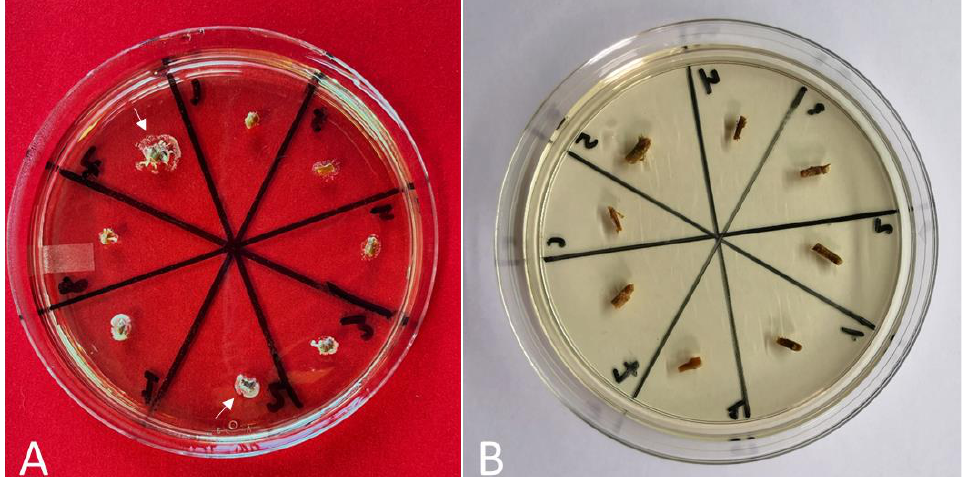
Figure 1. Indexing in vitro Malus spp. shoots for the presence of contamination on bacteriological growth medium 523. Shoots were grown 12 weeks (two subcultures of 6 weeks each) on medium supplemented with PPM TM (0.2% v / v ) and then transferred to medium without any PPM TM and cultured for four additional subcultures (total of 24 weeks of culture). ( A ) ‘Gold Rush’. ( B ) ‘Golden Delicious’. White arrows in A indicate the bacterial growth on and around the ‘Gold Rush’ explants and on bacteriological growth medium 523.